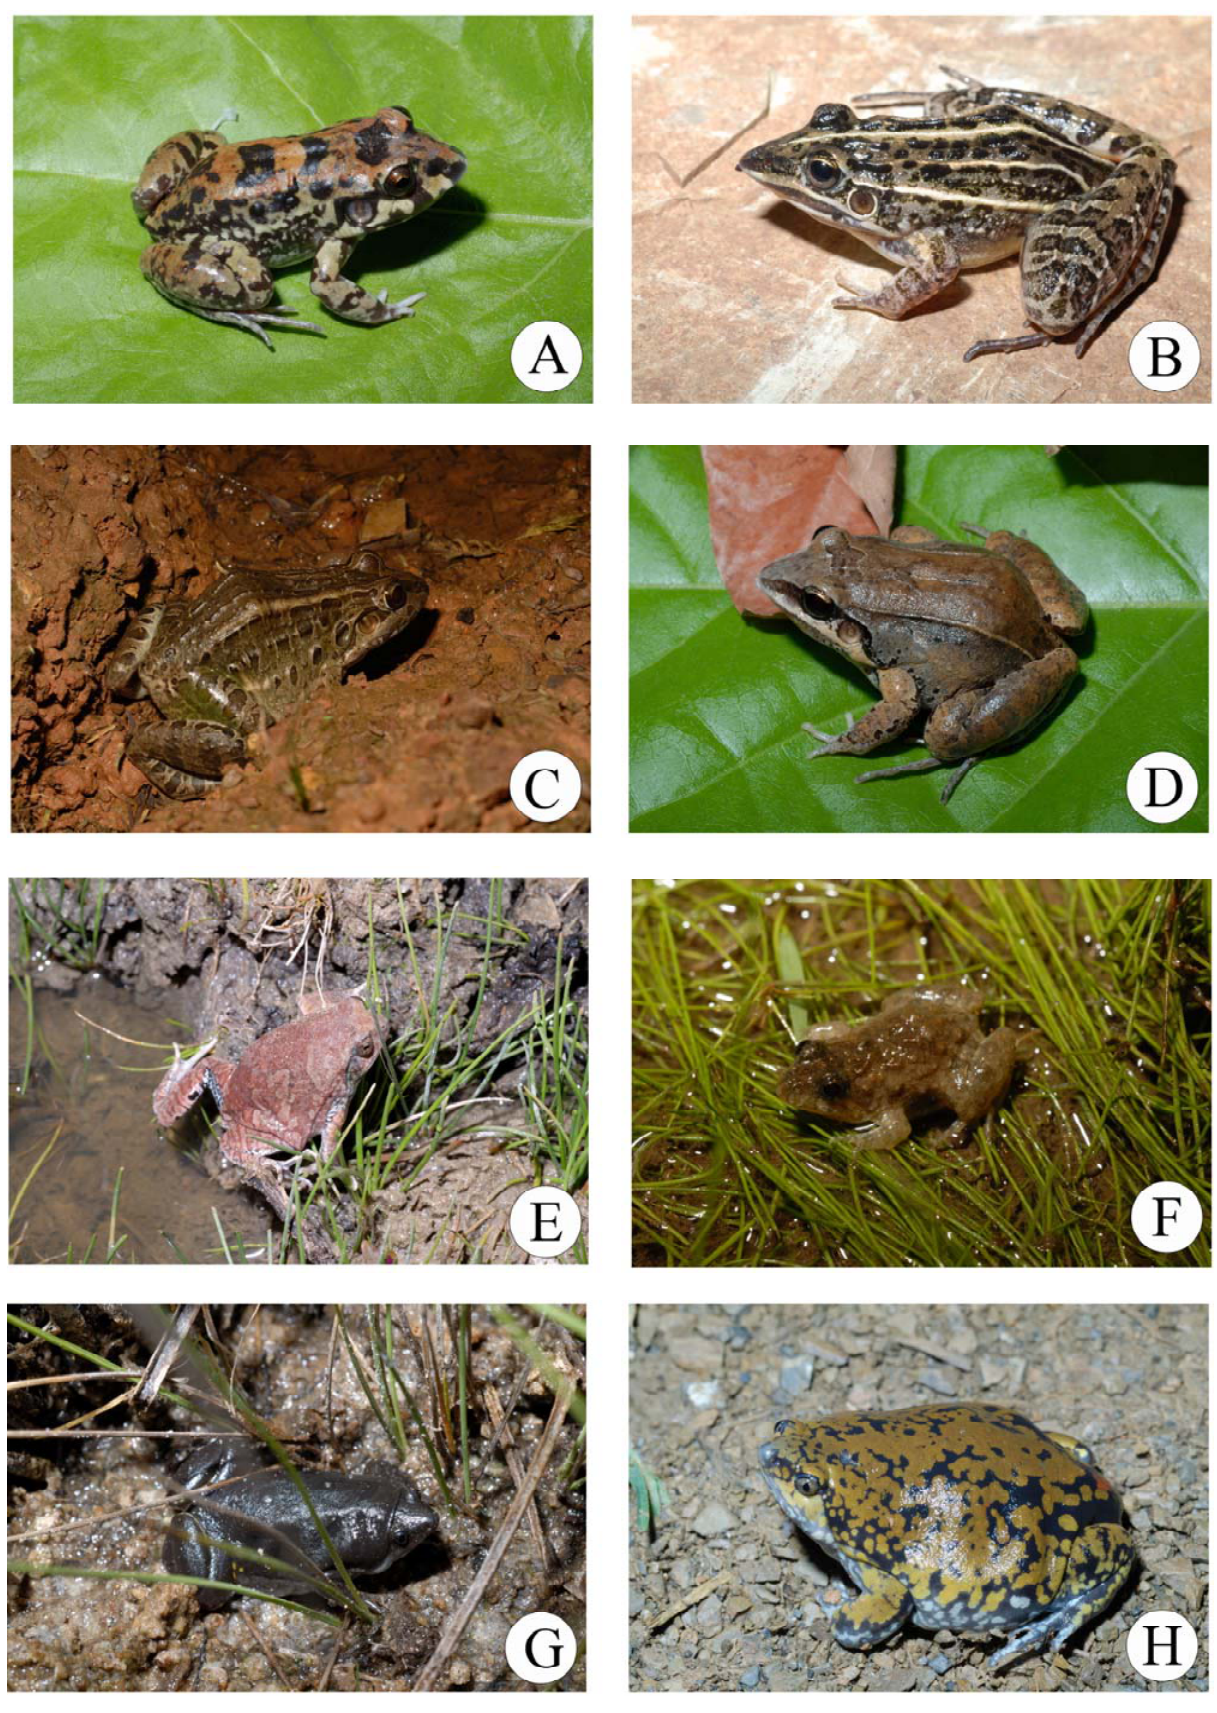
Figure 4. Leptodactylid species: A. Leptodactylus troglodytes ; B. Leptodactylus sertanejo ; C. Leptodactylus cf . chaquensis ; D. Leptodactylus mystaceus . Leiuperid species: E. Eupemphix nattereri ; F. Pseudopaludicola ternetzi. Microhylid species G. Elachistocleis ovalis ; H. Dermatonotus muelleri ; collected in the municipality of São Desidério, state of Bahia. Photo: P. H.